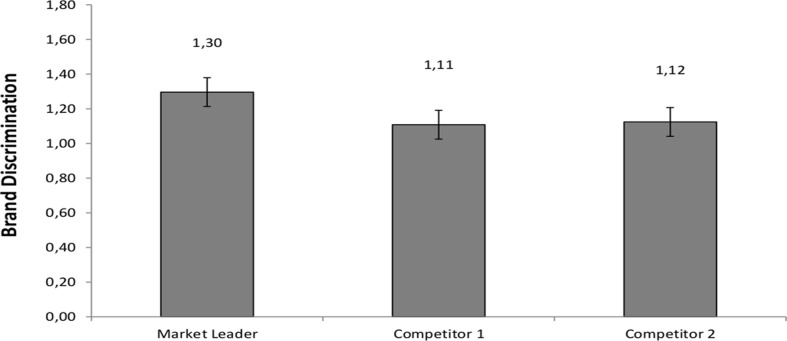
Brand Discrimination for the Market Leader brand and its two competitors, Study 1 A.Note: Standard error bars are shown for each mean.